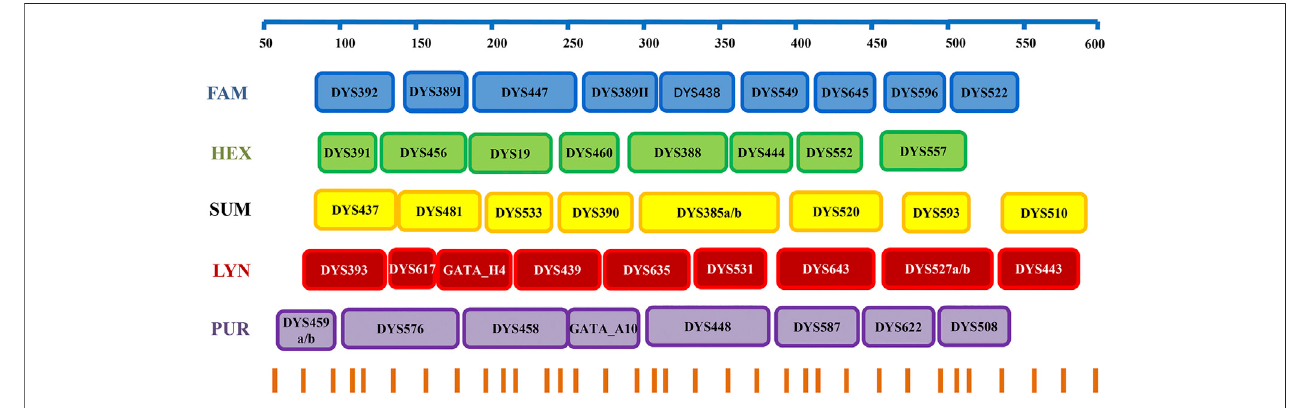
FIGURE 1 | Diagram of the Y45 kit with fi ve fl uorescent